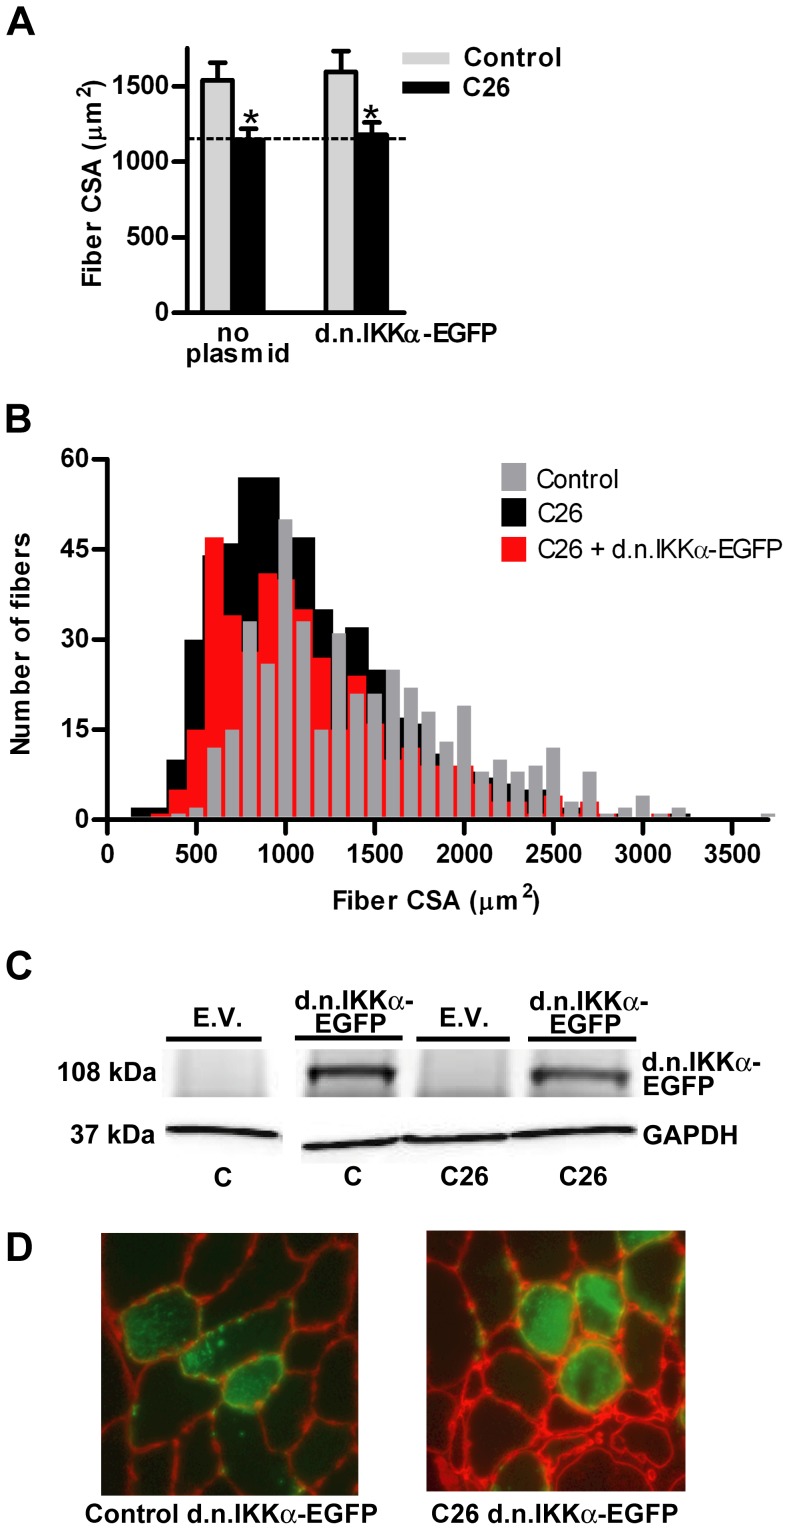
Effects of d.n.IKKα-EGFP on muscle fiber cross sectional area (CSA).(A) Mean tibialis anterior (TA) fiber cross-sectional area in control and C26 tumor-bearing mice in the presence or absence of d.n. IKKα-EGFP. Each bar represents mean fiber area from 8 muscles (± SE). (B) Fiber area frequency distribution of all fibers from muscles of control, C26, and C26 + d.n. IKKα-EGFP groups. (C) Western blots of lysates from TA muscles injected with the empty vector (EV) or d.n. IKKα-EGFP plasmid confirms overexpression of the fusion protein. d.n. IKKα-EGFP is 108 kDa. All samples are from the same immunoblot. (D) Representative cross sections of TA muscles from control and C26 tumor-bearing mice injected with the d.n. IKKα-EGFP plasmid. C  =  control. * significantly different from control (P<0.05).